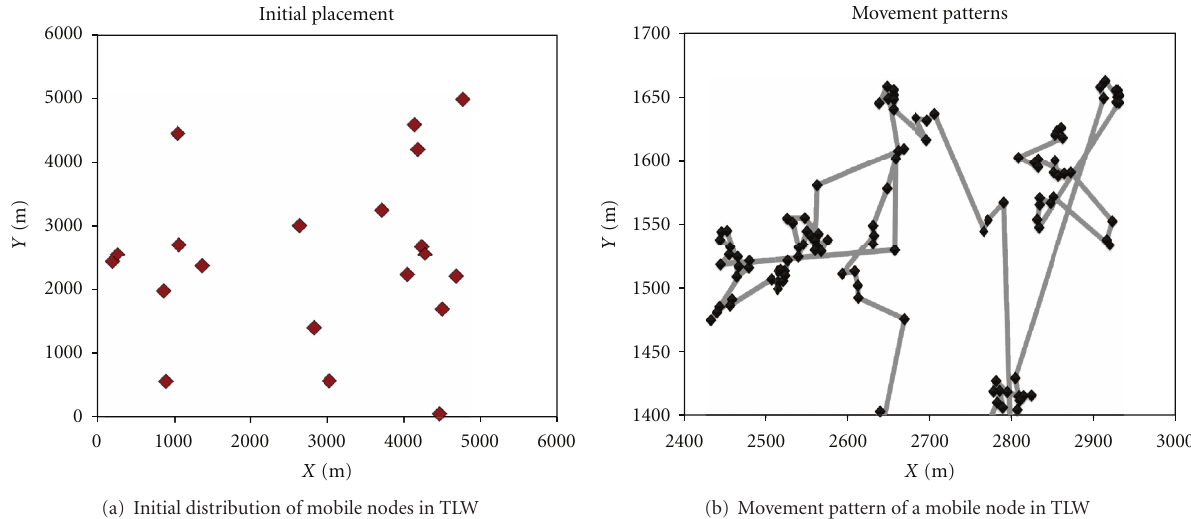
Figure 2: An example initial distribution and movement pattern in TLW. (Note that we restricted the scales of the axes in (b) to better visualize the detailed movements of one